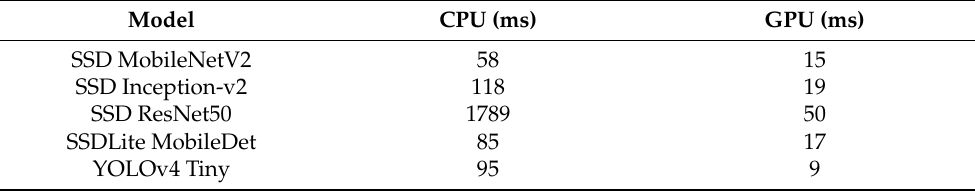
Table 10. Average inference times of the detectors on different hardware